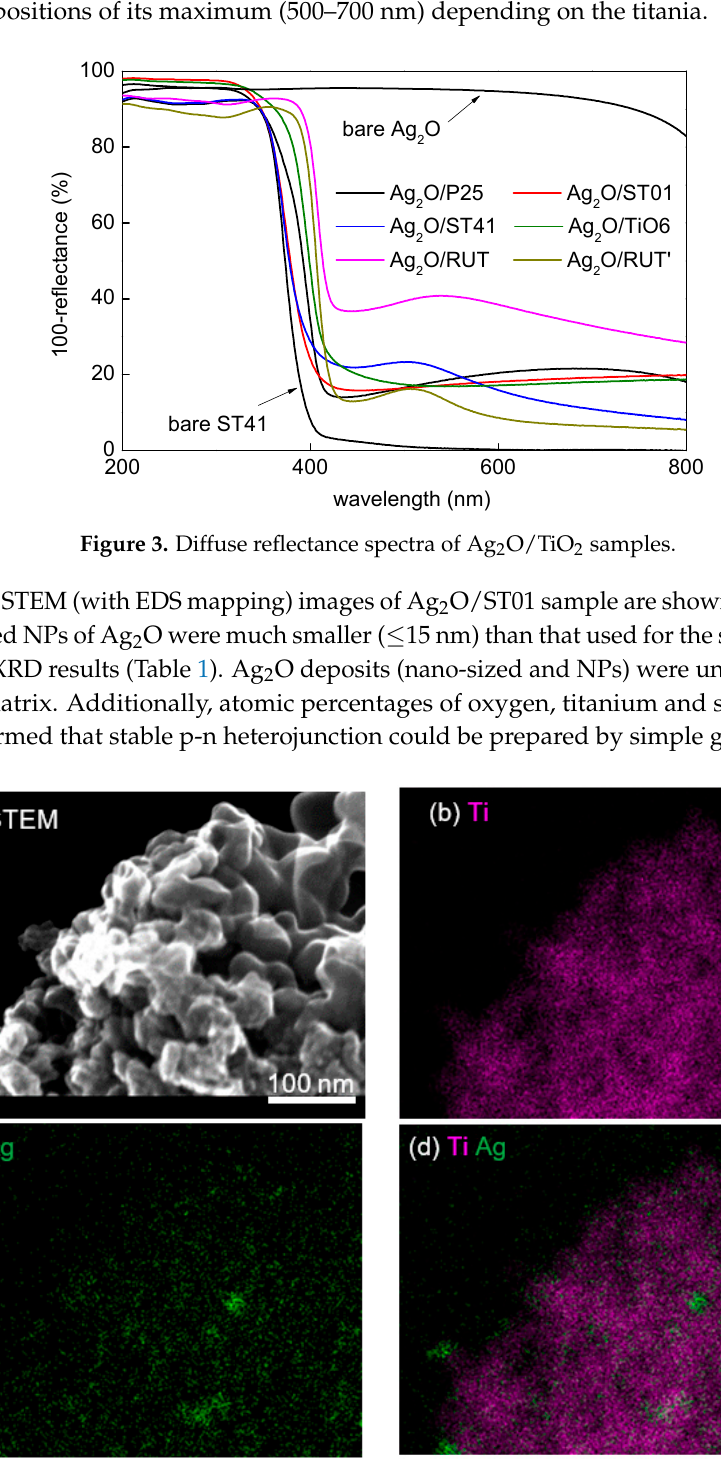
Figure 4. STEM ( a ) and EDS (Ti- ( b ), Ag ( c ) and merge of Ti and Ag ( d )) images of Ag 2 O/ST01.